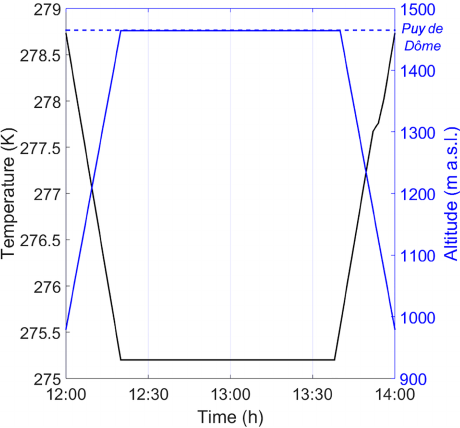
Figure 2. Temperature and altitude profiles prescribed to simulate the occurrence of a non-precipitating orographic cloud at the top of Puy de Dôme mountain.